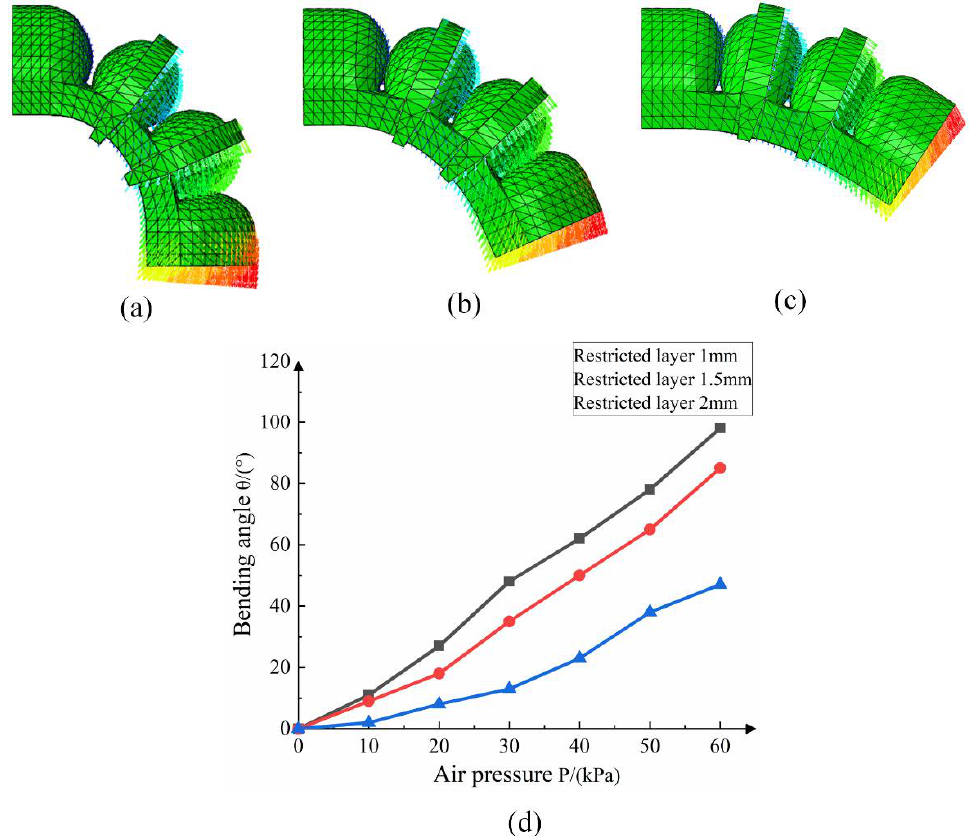
Figure 11. Analysis of the influence of the thickness of the confinement layer on the bending